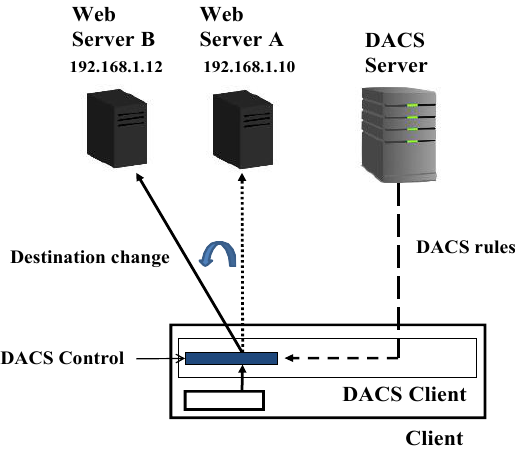
Figure.12 Destination Change on the DACS